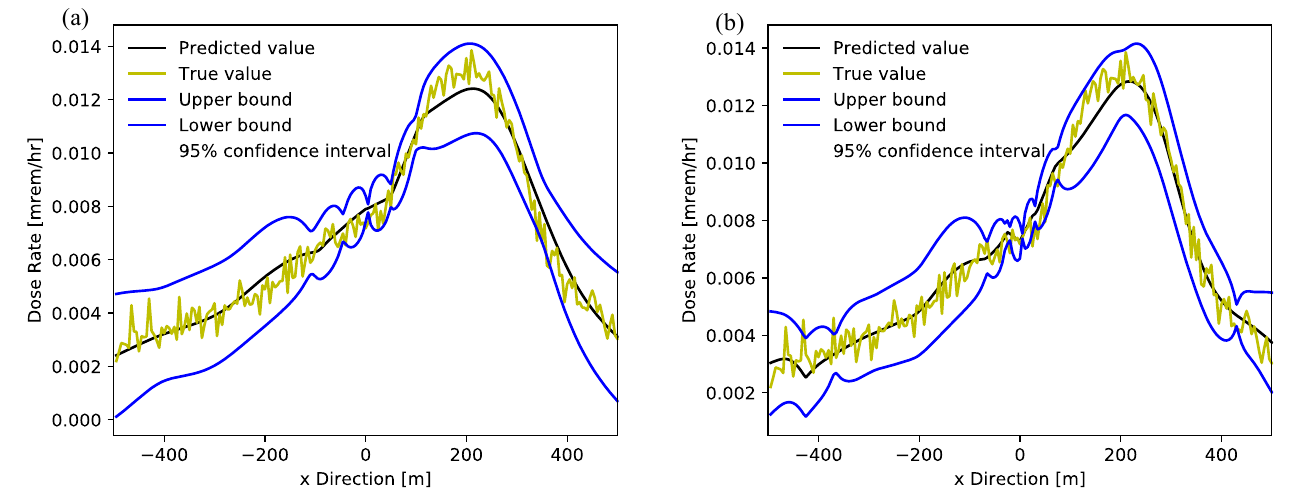
Figure 6. The calculated prediction uncertainty through y = 0 for ( a ) the five-sensor and ( b ) seven- sensor surveys demonstrating that prediction uncertainties decrease near the vicinity of observed locations.